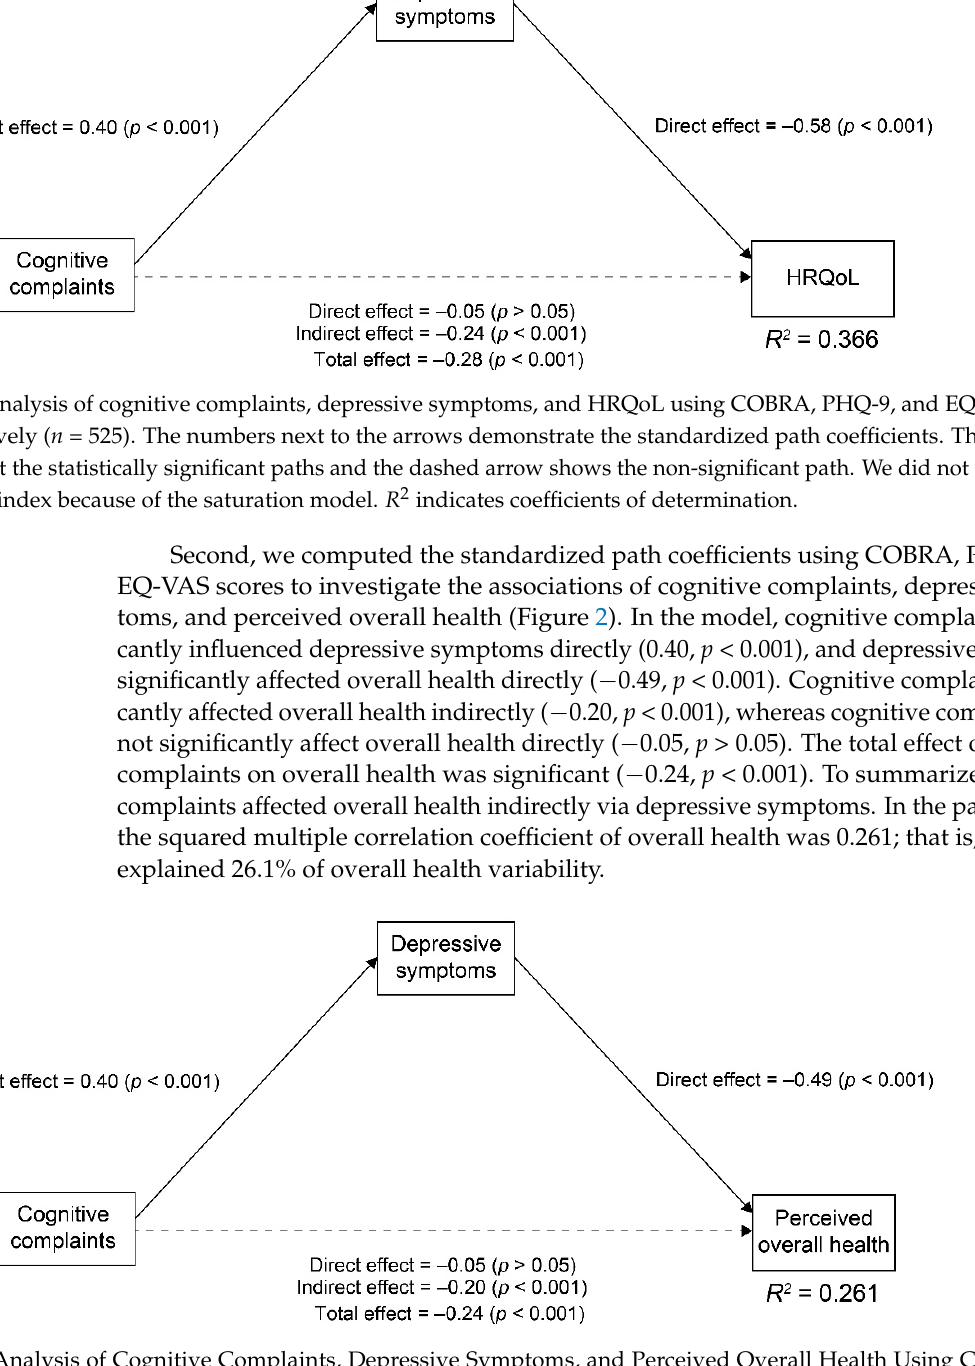
Figure 2. Path Analysis of Cognitive Complaints, Depressive Symptoms, and Perceived Overall Health Using COBRA, PHQ-9, and EQ-VAS Scores, respectively ( n = 525). The numbers next to the arrows demonstrate the standardized path coefficients. The solid arrows represent the statistically significant paths, and the dashed arrow shows the non-significant path. We did not use the goodness-of-fit index because of the saturation model. R 2 indicates coefficients of determination.